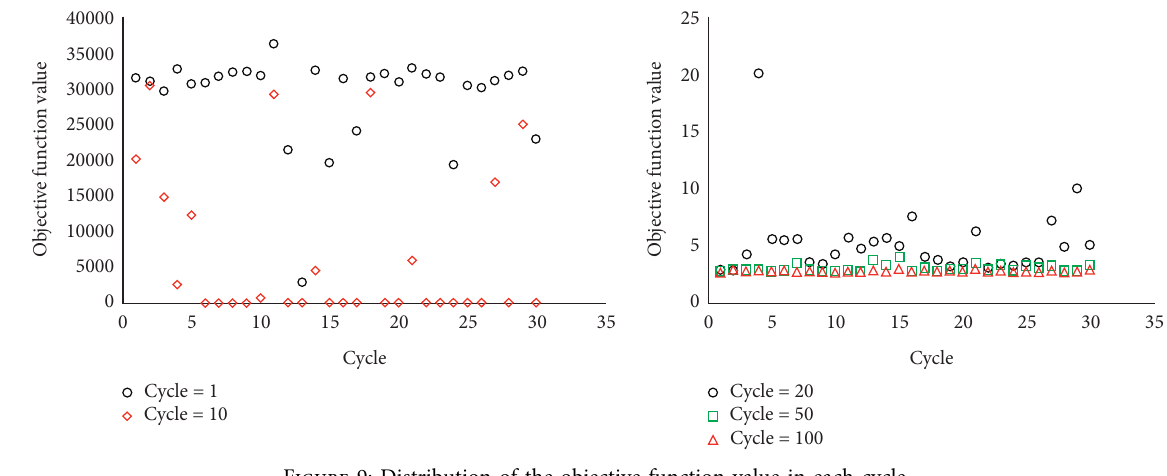
Figure 9: Distribution of the objective function value in each